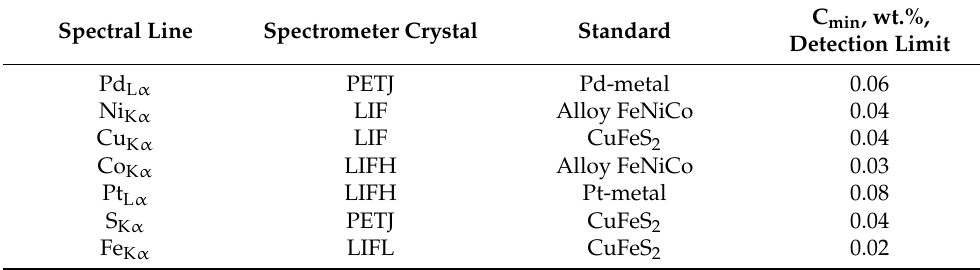
Table 1. The standards and detection limits for microprobe analysis. Spectral